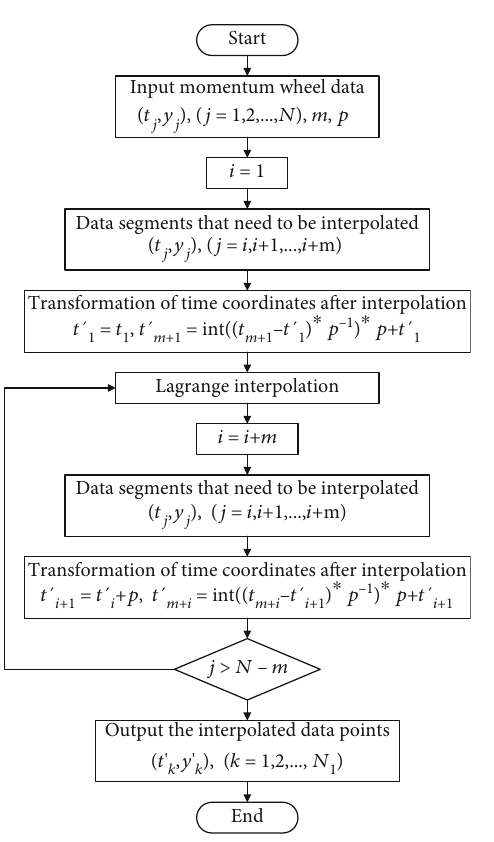
Figure 2: The fl ow chart of equal interval interpolation